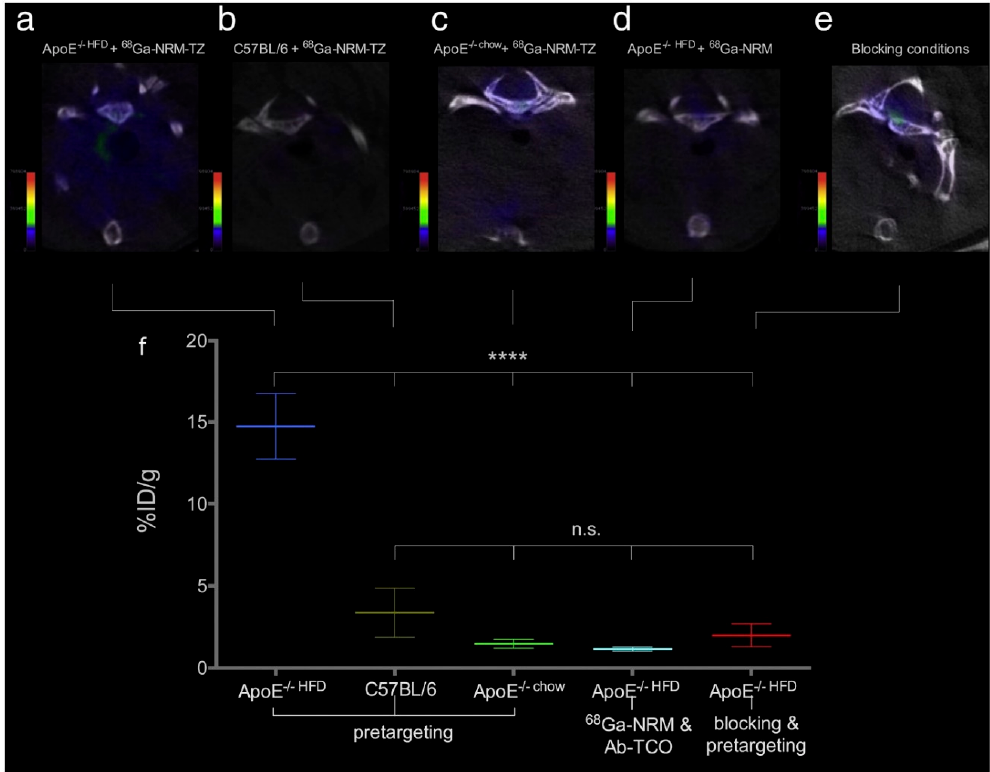
Figure 11. ( a – e ) Axial positron-emission tomography (PET)/computed tomography (CT) images taken 24 h post injection of E06-TCO and 1 h post-injection of NPs: ( a ) ApoE − / − HFD mice injected with 68 Ga-NRM-TZ; ( b ) C57BL/6 mice injected with 68 Ga-NRM-TZ; ( c ) ApoE − / − chow mice injected with 68 Ga-NRM-TZ; ( d ) ApoE − / − HFD mice injected with 68 Ga-NRM; ( e ) ApoE − / − HFD mice injected with antibody (Ab), prior to Ab-TCO and 68 Ga-NRM-TZ. ( f ) Radioactivity uptake in mice aortas for the five conditions, detected with a gamma counter 2 h post injection and expressed as the percentage of injected dose per gram of tissue (mean ± standard deviation; statistical analysis by two-tailed t -test, N = 3–5; ****, p = 0.0009). Reproduced with permission from Reference [153].